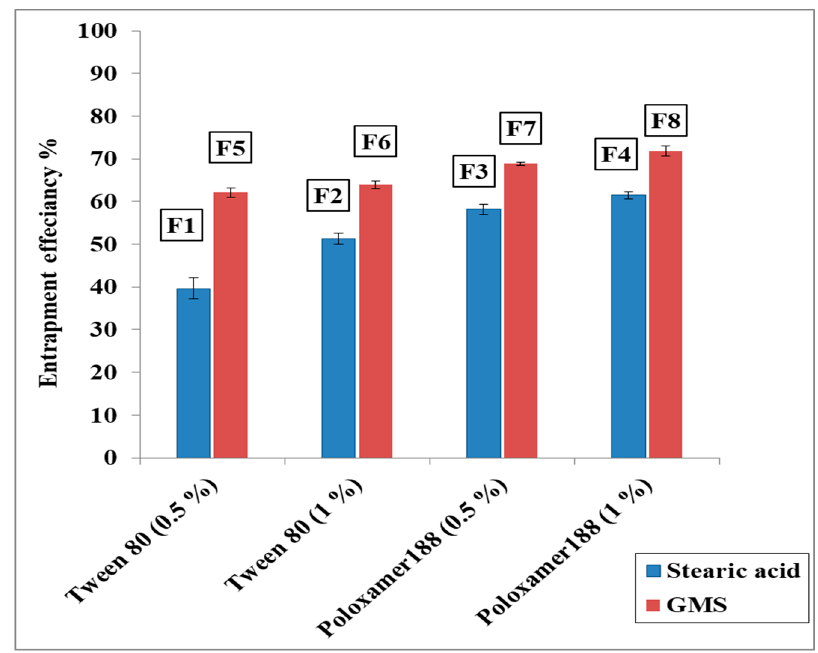
Figure 1. The effect of lipid type and surfactant concentration on the entrapment efficiency% of Figure 1. The e ff ect of lipid type and surfactant concentration on the entrapment e ffi ciency% of carbamazepine in the prepared carbamazepine solid lipid nanoparticles formulations. carbamazepine in the prepared carbamazepine solid lipid nanoparticles